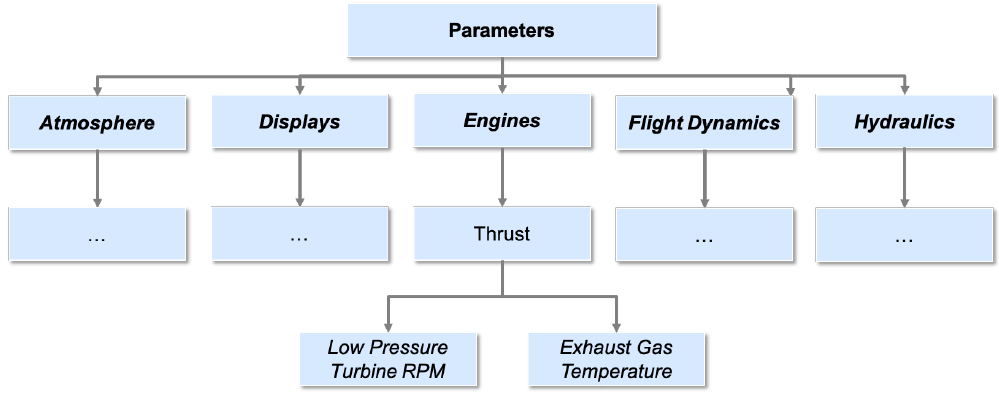
Figure 3. Notional hierarchical parameter decomposition in typical FOQA